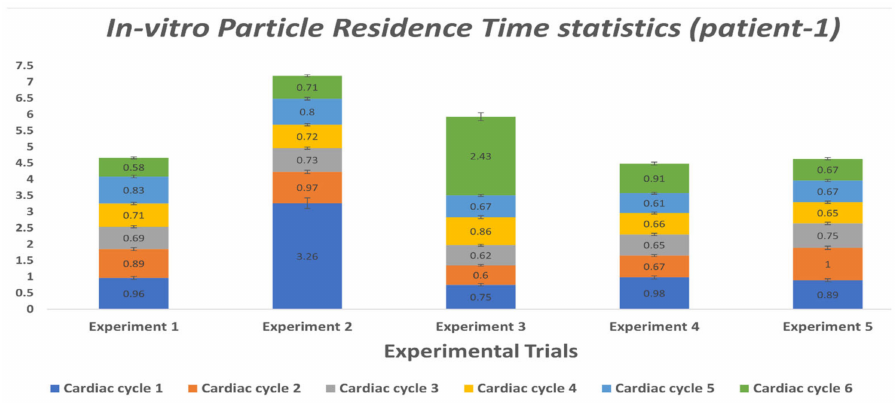
Figure 25. Average PRT values derived from tracked particles over six cardiac cycles in the MPA conduit for patient 1. Each stacked value represents an average PRT in each cardiac cycle.